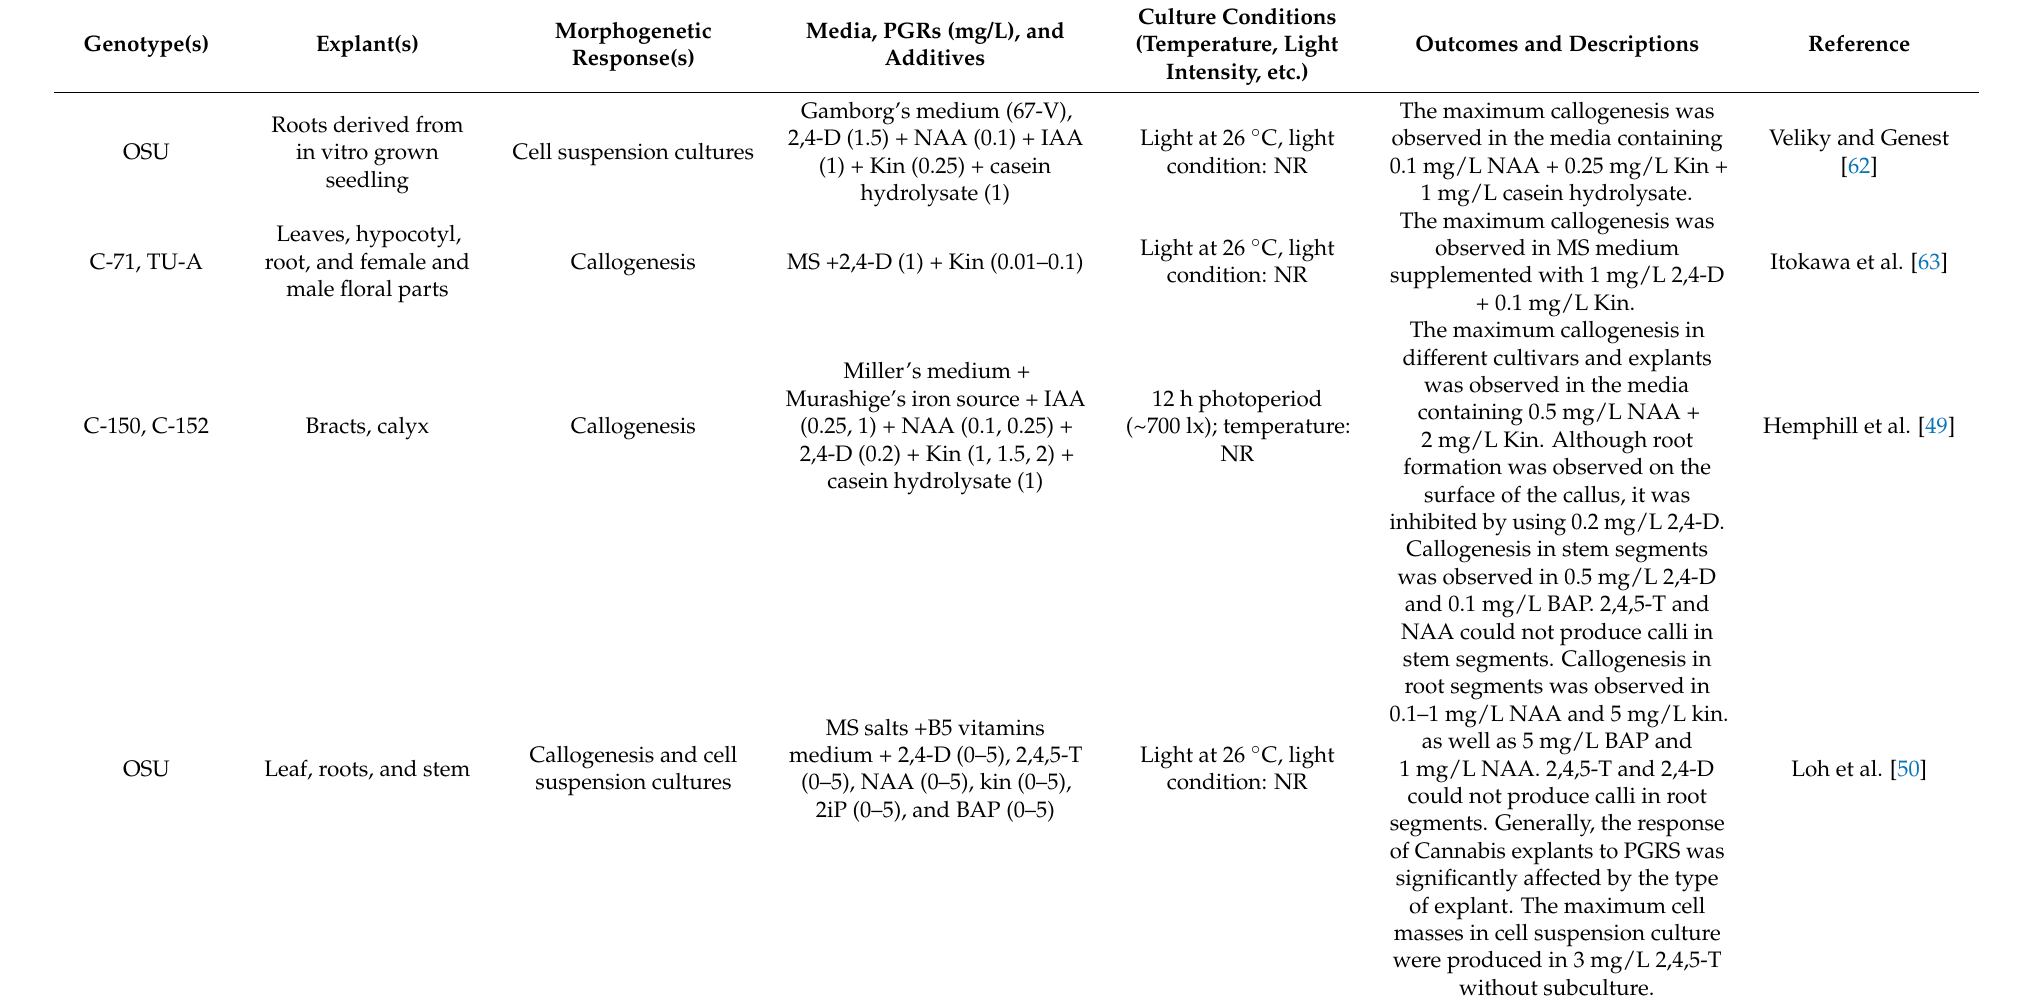
Table 2. In vitro regeneration studies in